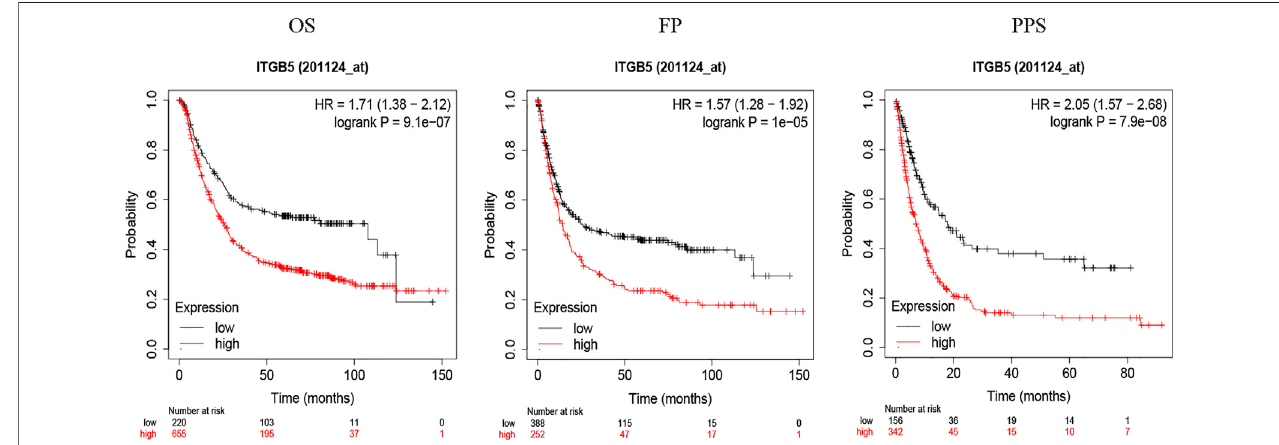
FIGURE 8 | The prognostic value of ITGB5 in GC (Kaplan – Meier Plotter).